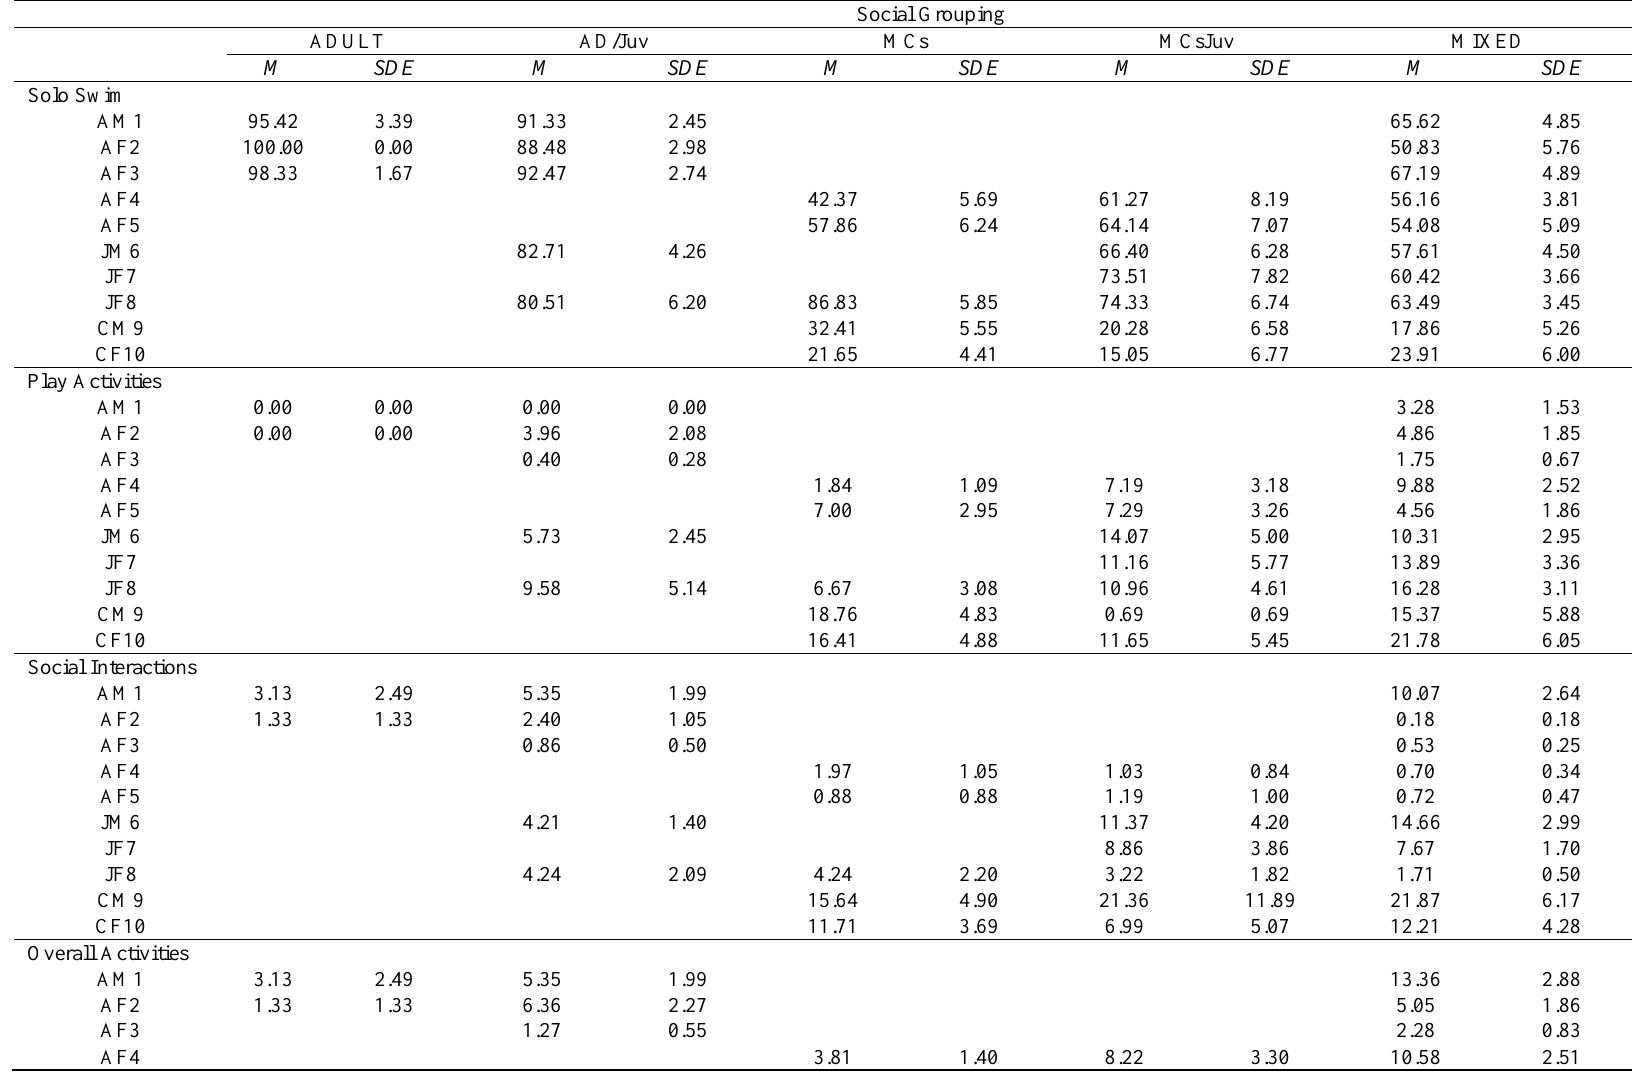
Individual Descriptives per Behavioral Category per Social